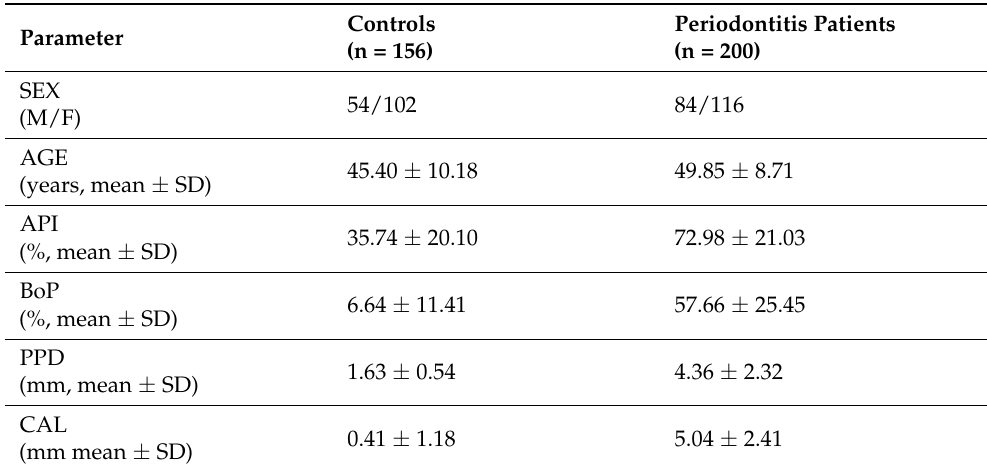
Table 1. The clinical periodontal parameters of the studied